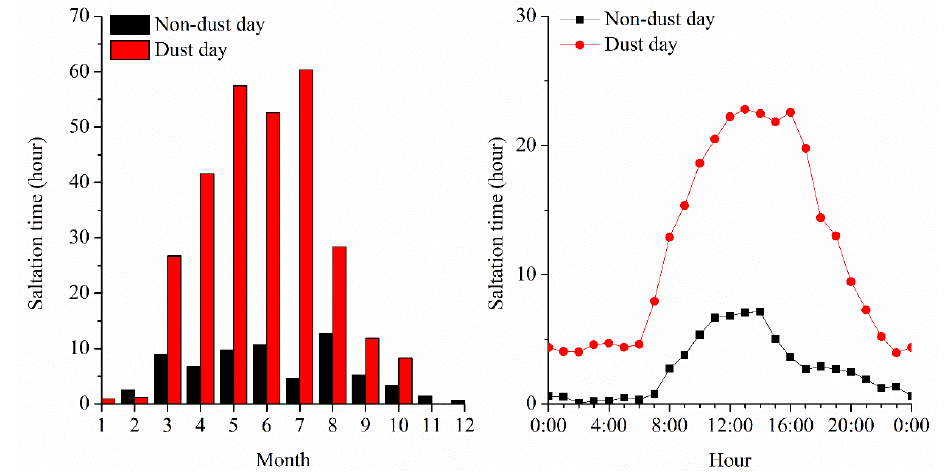
Figure 6. Monthly and diurnal variations in the saltation time on dust and non-dust days. Figure 7 shows the relative distributions of hourly saltation time on dust and non-dust days. As demonstrated, values were significantly higher on non-dust days than dust days when the hourly saltation time was lower than 0.15 h. The result was re- versed when the hourly saltation time was higher than 0.15 h. In the interval of 1.0 h, only 52.7% of saltation events lasted for less than 0.1 h on dust days, whereas the corre- sponding value for non-dust days was 81.3%. Furthermore, only 63.2% of the saltation events endured for less than 0.2 h on dust days, whereas for non-dust days, the propor- tion is as high as 92.4%. Only 2.4% of the saltation events lasted a sufficient amount of for non-dust days, only 0.1% stayed for the sufficient period—0.9 to 1.0 h. These results